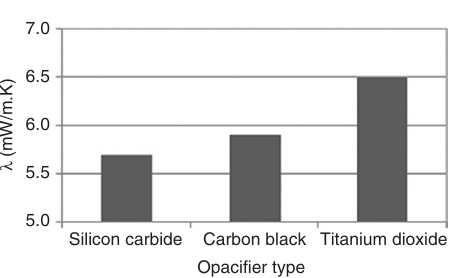
Figure 6 Thermal conductivity coefficient change of VIP according to opacifier type.